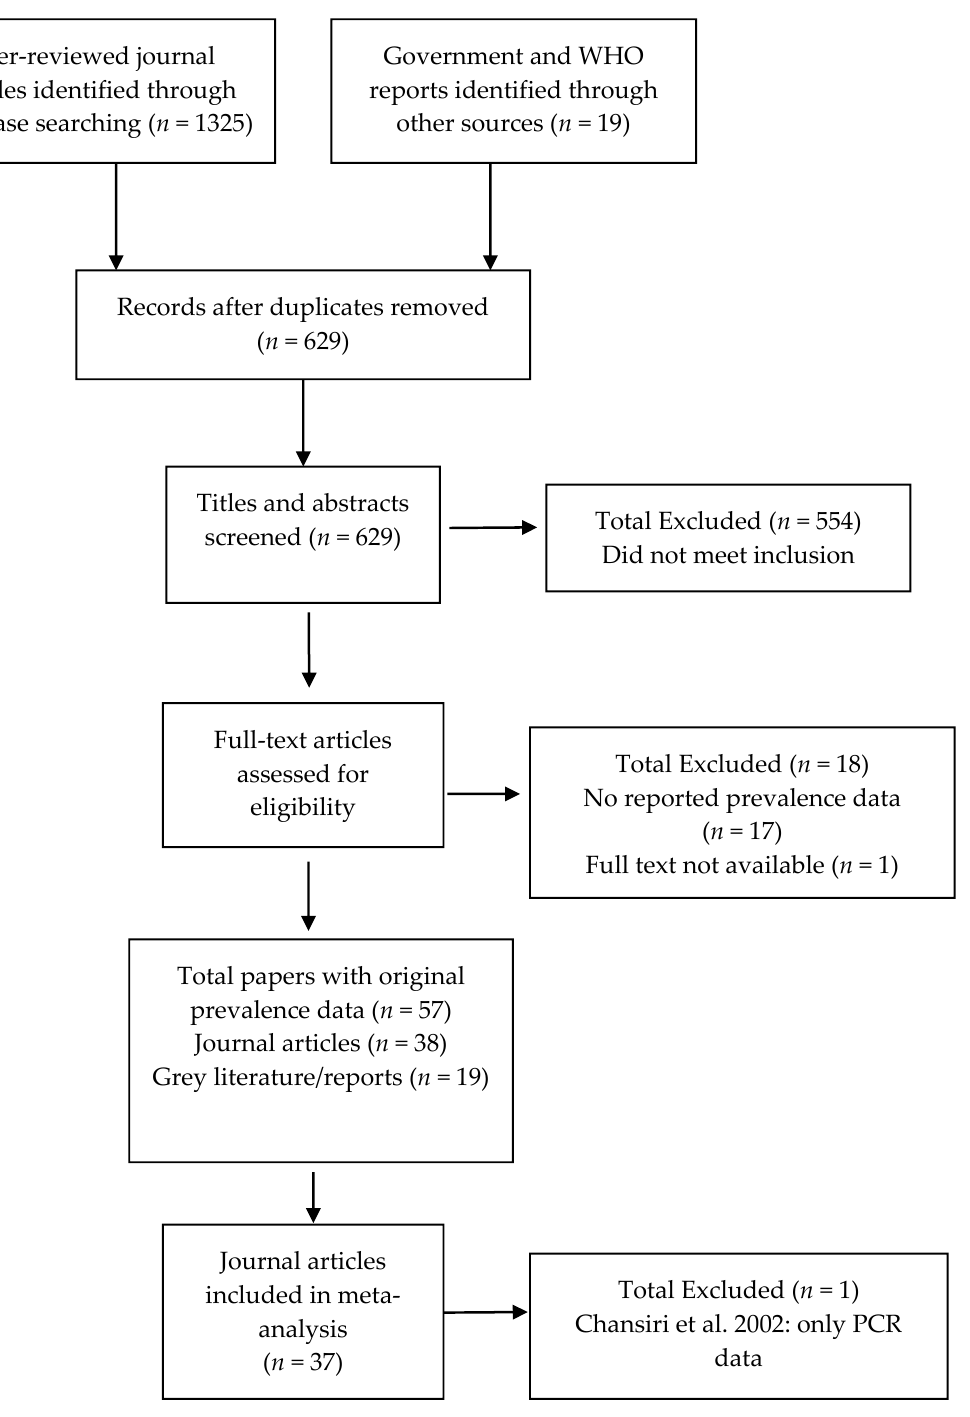
Figure 1. Study selection flow chart.